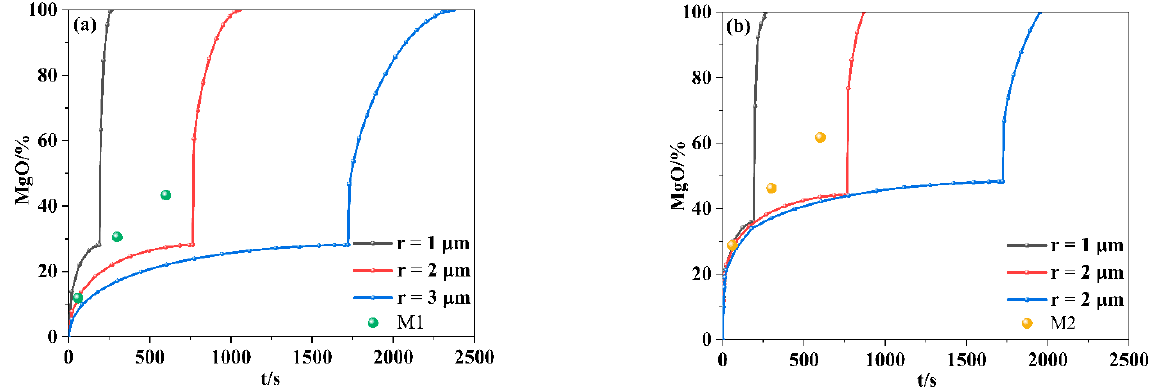
Figure 13. Variation of MgO content in inclusions with time. ( a ) sample M1, ( b ) sample M2.